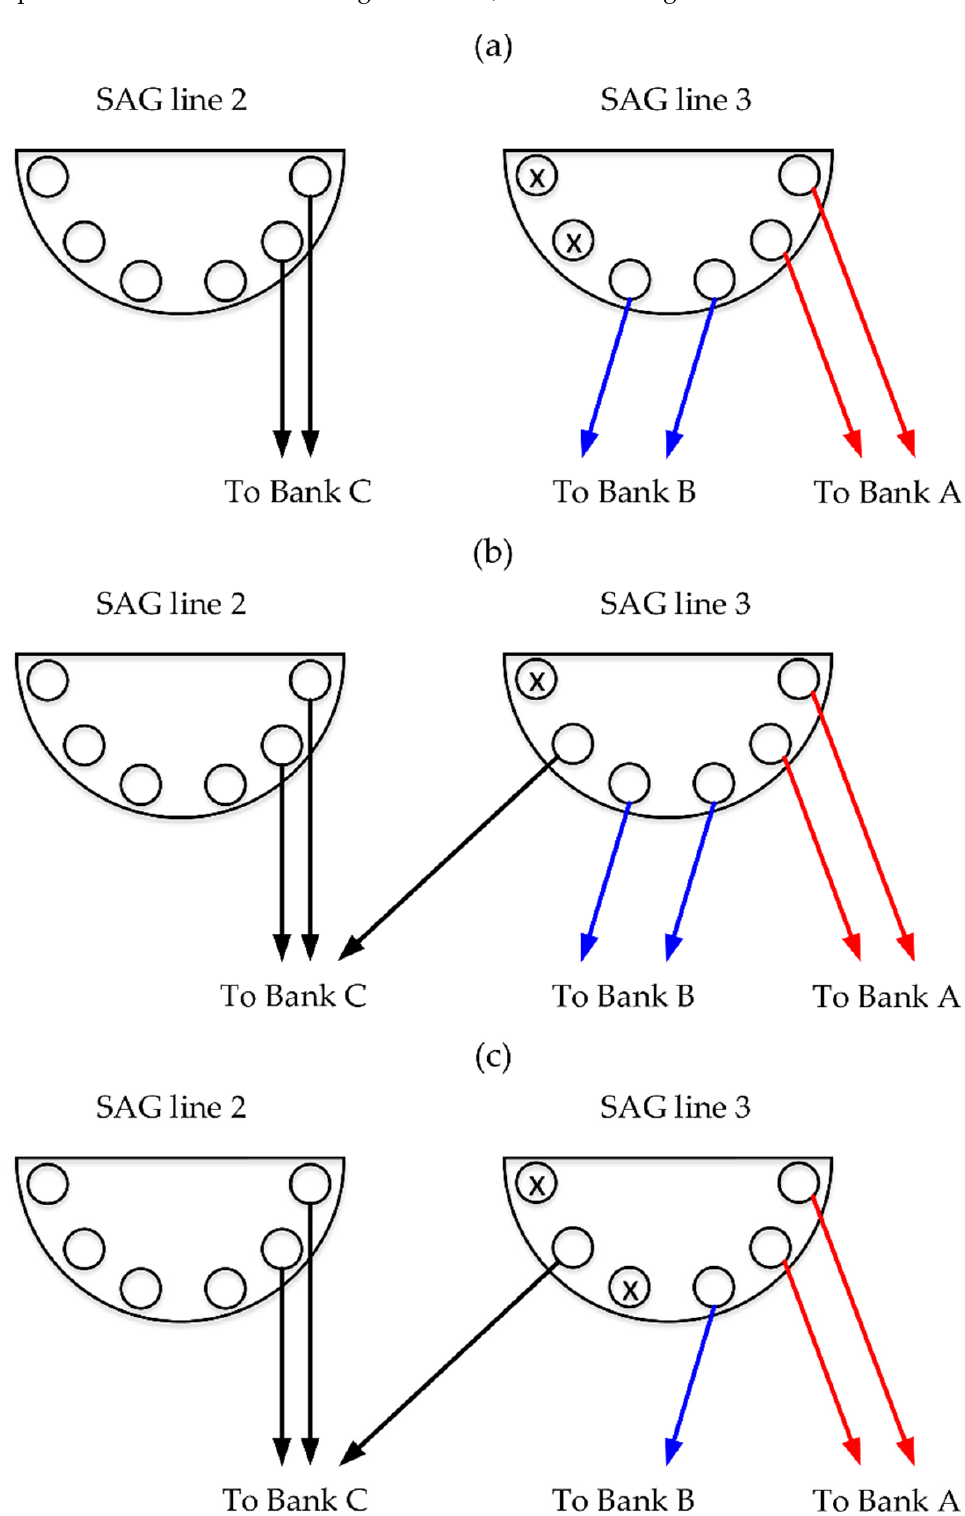
Figure 2. Valve configuration in the feed distributors of SAG lines 2 and 3: ( a ) Baseline; ( b ) Alternative valve setting 1; ( c ) Alternative valve setting 2.